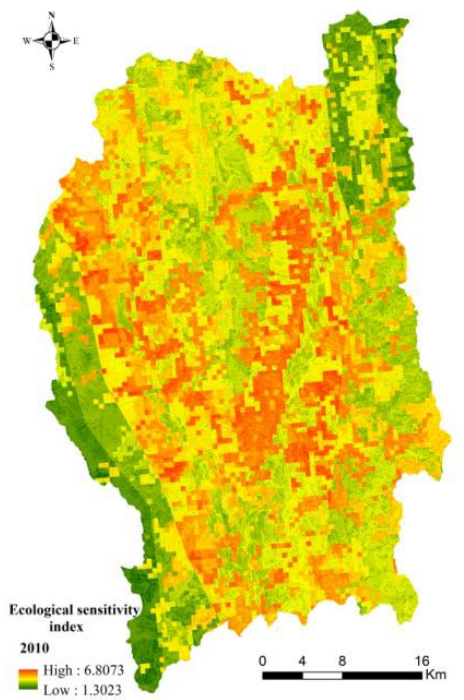
Figure 5. Area under ROC (AUC) value of each land use type.